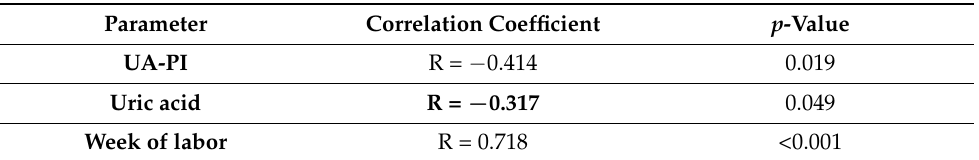
Table 3. Analysis of the correlations between birth weight and the parameters evaluated within the group with neonates below the 3rd